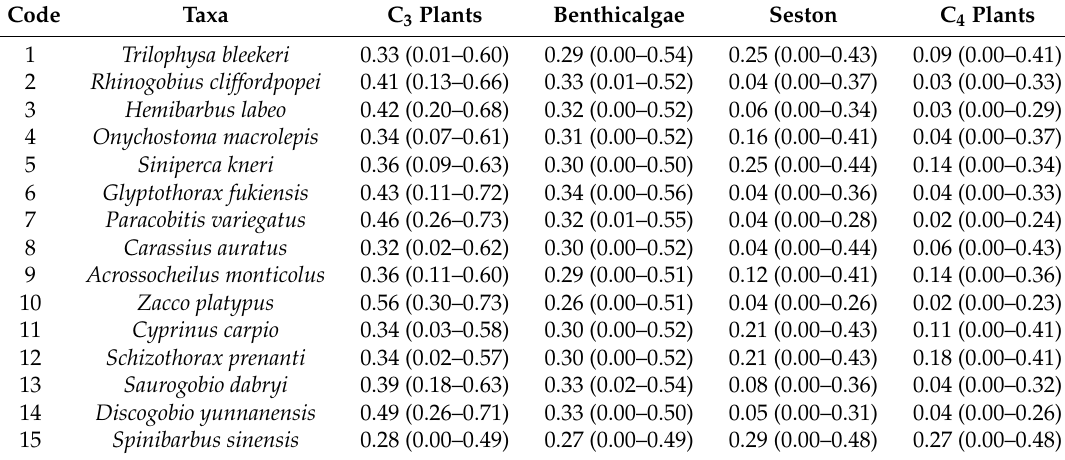
Table 2. Bayesian isotopic mixing model estimates of the highest likely percent contributions (95% BCI, Bayesian credibility interval) of basal carbon sources to fish species collected from the upstream of the Daning